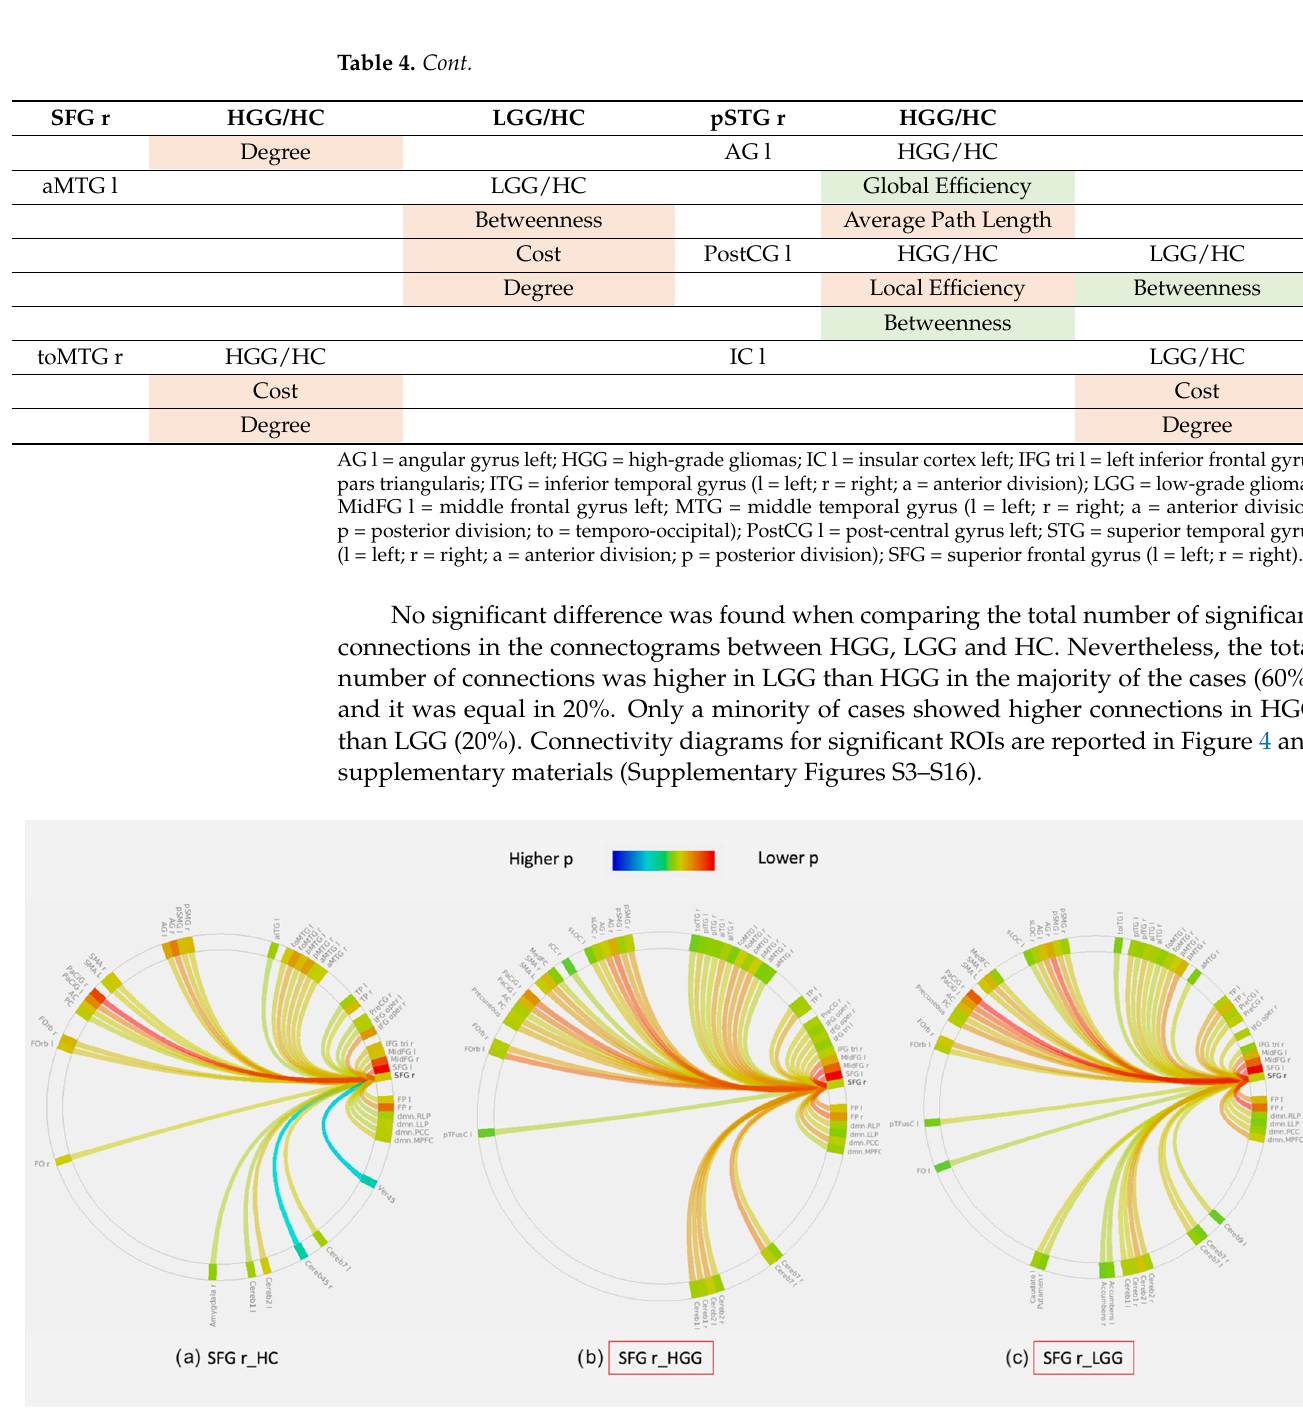
Figure 4. Example of whole-brain connectivity diagrams generated by seeding of the right superior frontal gyrus (SFG r) in healthy controls (HC, ( a )), left-hemispheric high-grade gliomas (HGG, ( b )) and left-hemispheric low-grade gliomas (LGG, ( c )). The red square in diagrams ( b ) and ( c ) indicates that there was a significant difference in functional connectivity in this seed for HGG and LGG compared to HC ( a ). The color scale of the links represents their statistical significance ( p -value FDR corrected, only links with p < 0.05 are included). Regions of interest (ROI) in the diagrams are labeled as per the AAL atlas (available in CONN toolbox at https://web.conn-toolbox.org, accessed on 3 March 2022).